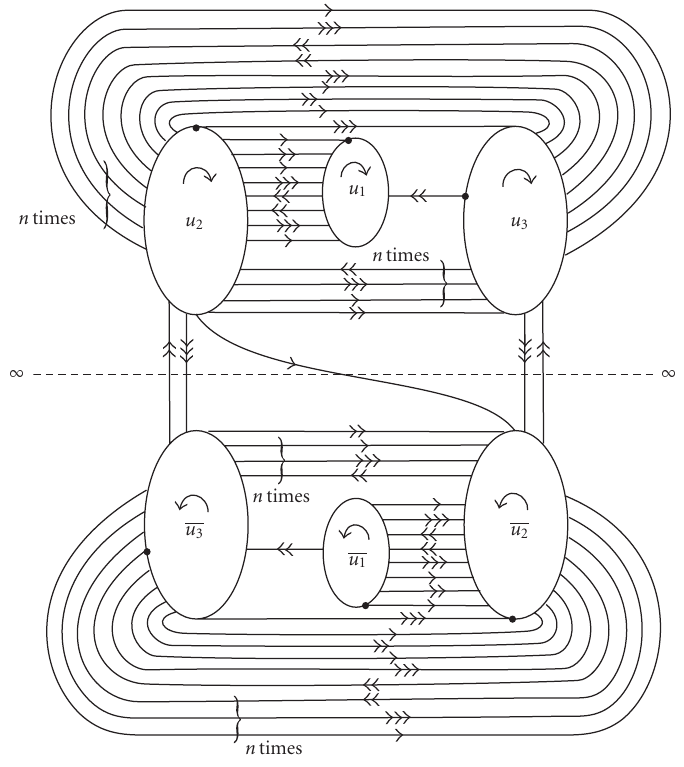
Figure 4.1. The irreducible diagram of Im and Kim ( n =